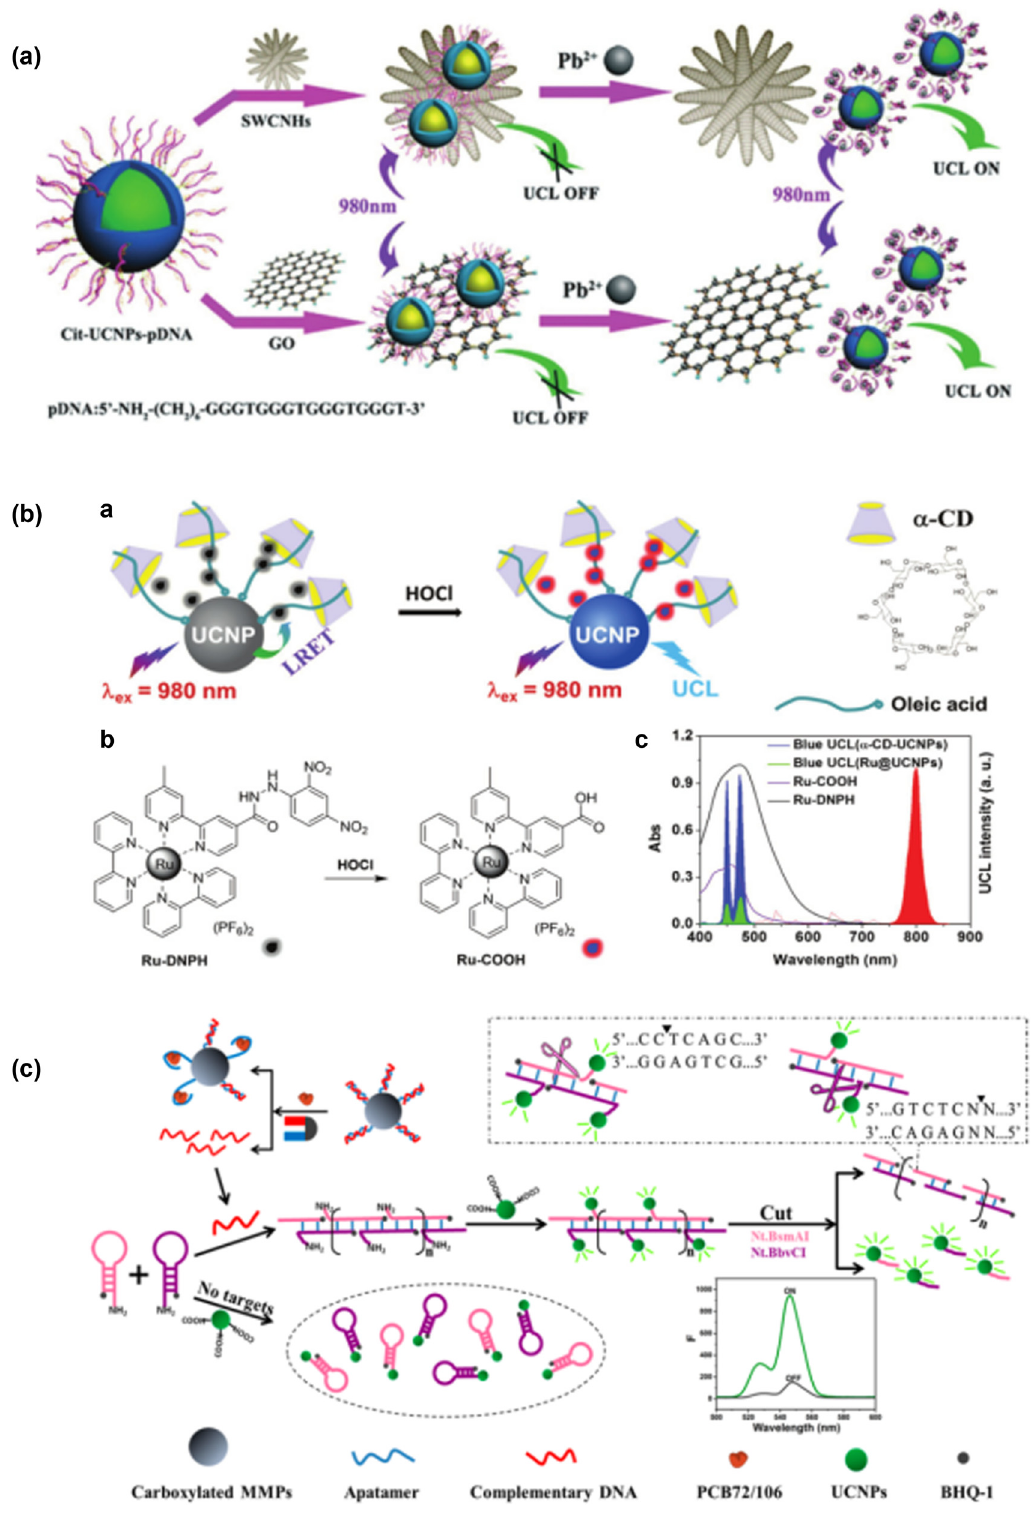
Figure 6: Schematic diagram of upconversion nanotechnology applied in detection of heavy metals and other pollutants; ( a ) schematic diagram of Pb 2 + detection [ 140 ] ; ( b ) schematic diagram of LRET system and HClO detection [ 144 ] ; ( c ) dual ampli fi cation strategy of upconversion fl uorescence aptamer based on HCR and endonuclease for detection of PCB 72/106 [ 145 ]